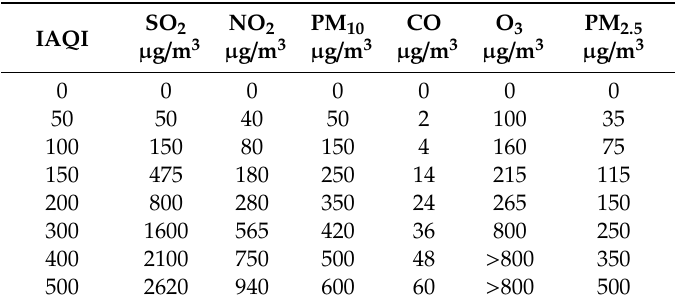
Table A1. Threshold of individual air quality index and concentration of pollutant item.